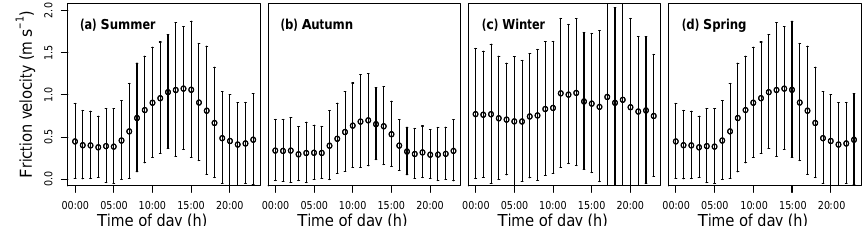
Figure 2. Mean ( ± standard deviation) diurnal pattern of friction velocity ( u ∗ ) at 43m above the soil surface for summer (a) , autumn (b) , winter (c) and spring (d)